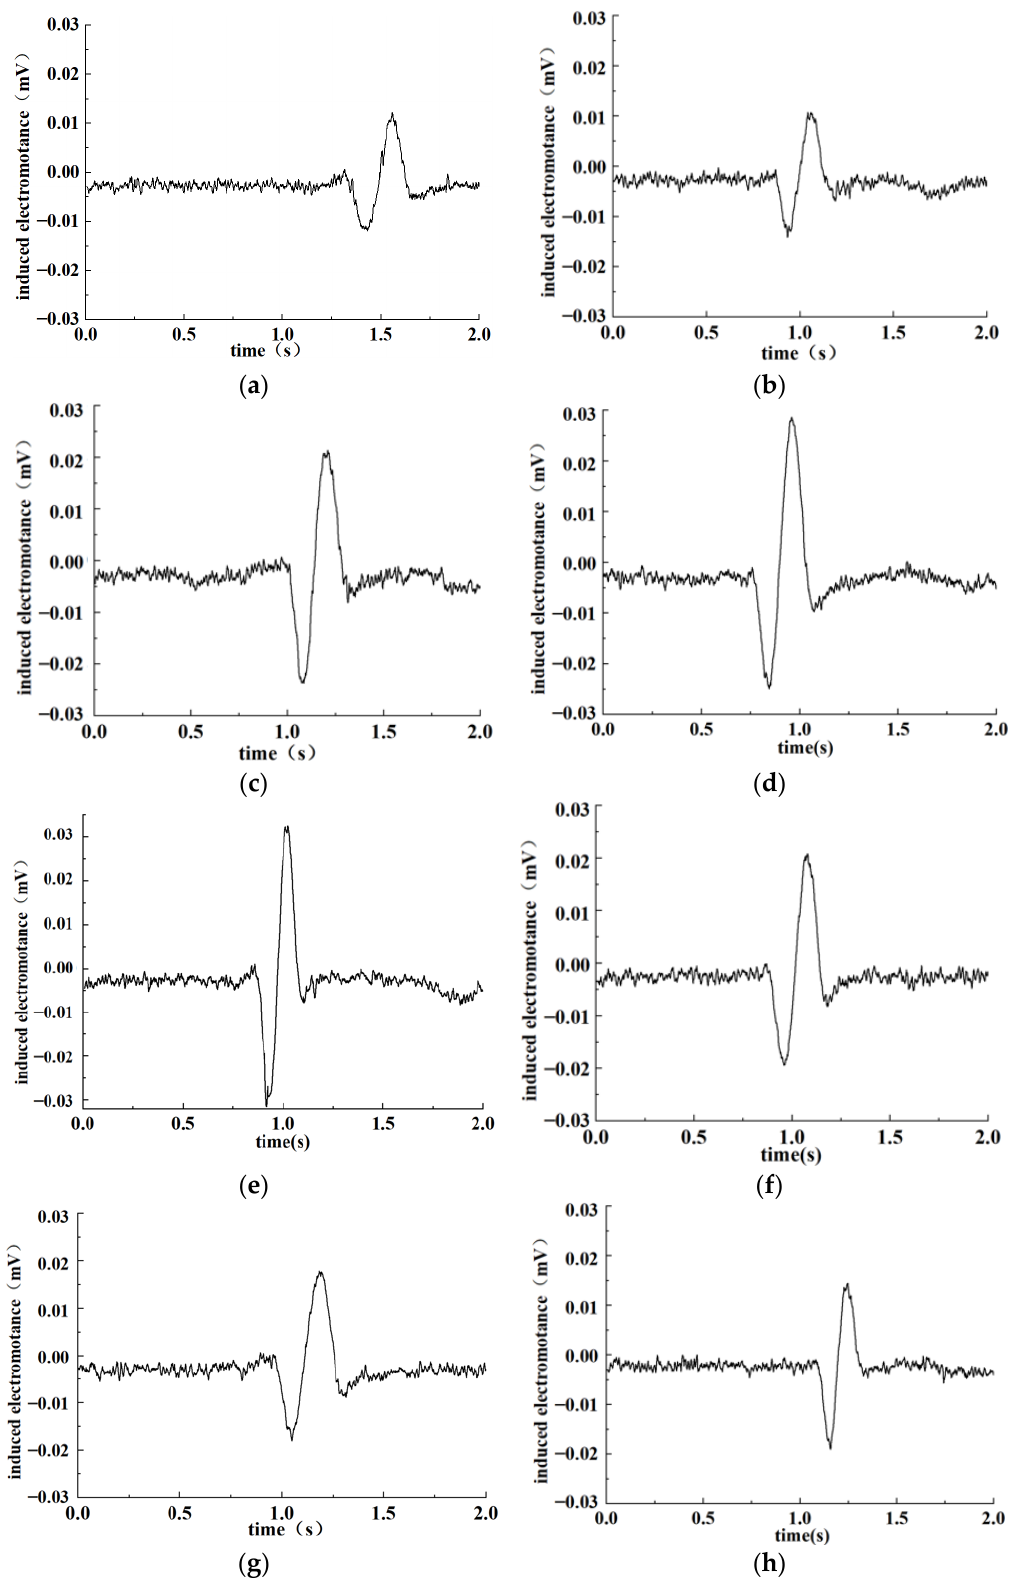
Figure 10. Test results under different raw output voltage conditions. ( a ) 3.1 V; ( b ) 3.62 V; ( c ) 3.9 V; ( d ) 4.3 V; ( e ) 4.49 V; ( f ) 4.63 V; ( g ) 4.8 V; ( h ) 5 V.